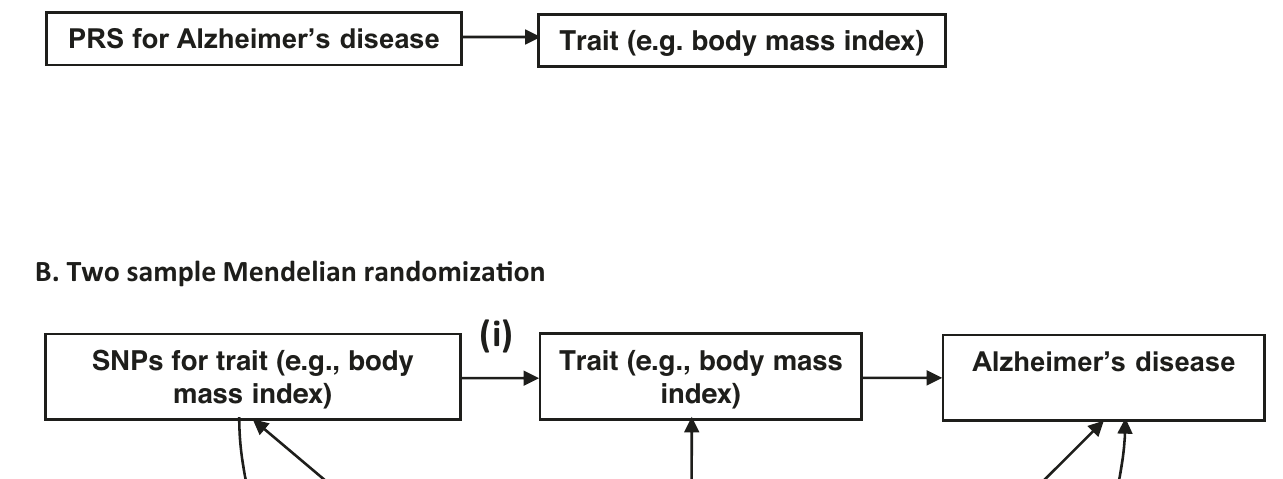
directionality of the observed associations. In B , we test the hypothesis that the trait (e.g., body mass index) causally affects liability to Alzheimer's disease, pro- videdthat the conditions (i), (ii), and (iii) are satis fi ed.The polygenicrisk score